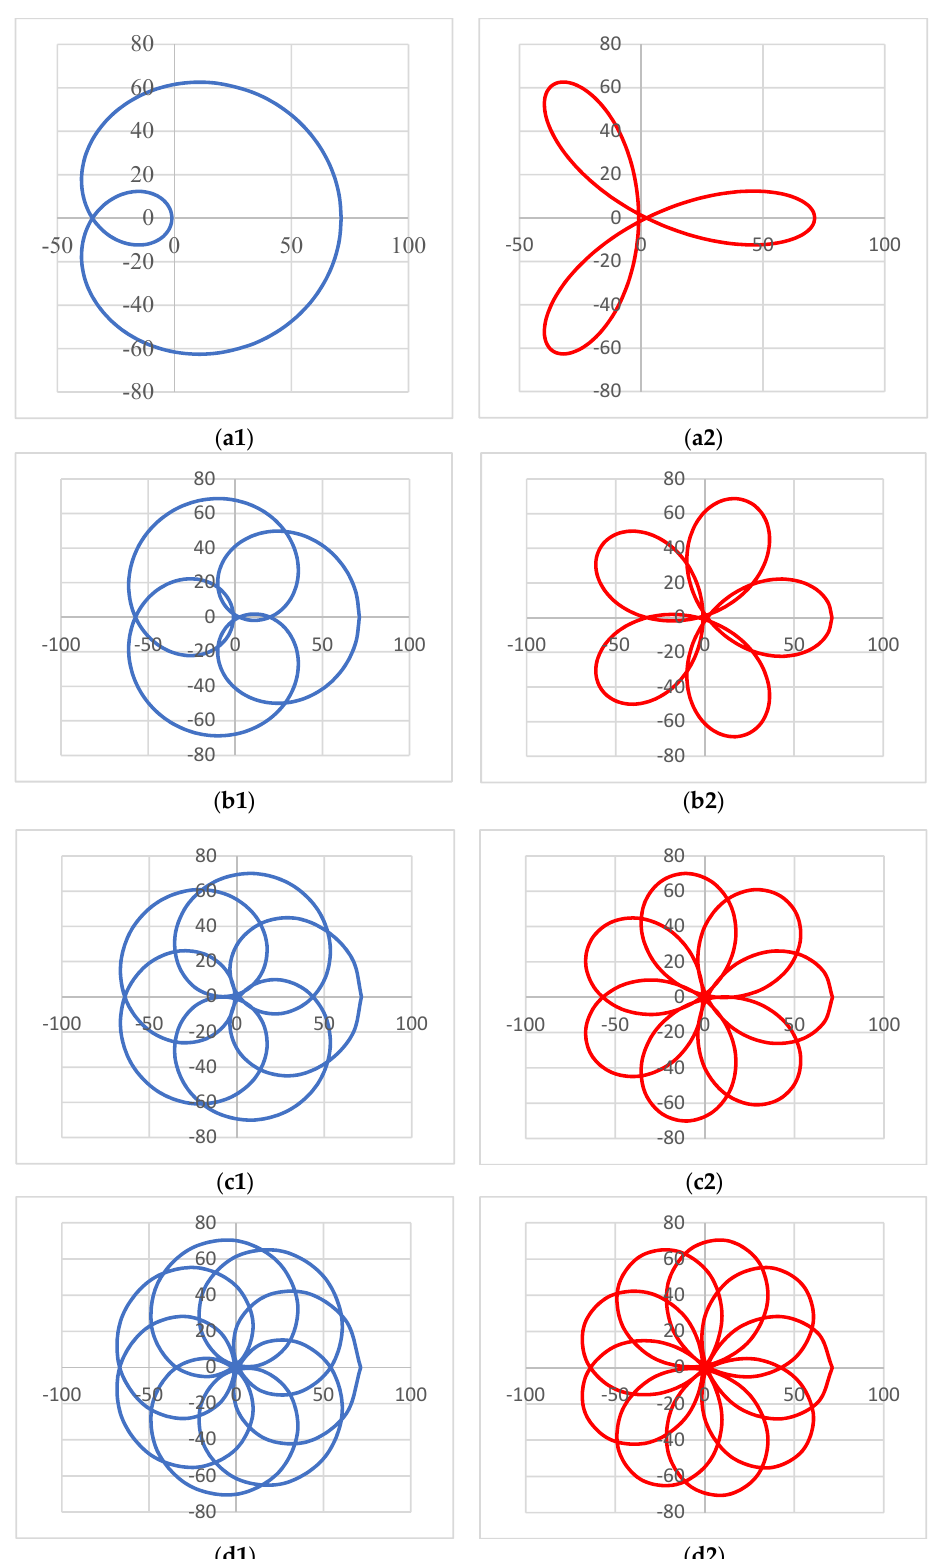
Figure 4. Study of the scan patterns produced by a pair of rotational Risley prisms (i.e., the configuration ba-ab in Figure 2d) for L = 1 m, e = 25 mm and for: ( a ) | M | = 2; ( b ) | M | = 4; ( c ) | M | = 6; ( d ) | M | = 8. ( 1 ) Left column, M > 0; ( 2 ) right column, M < 0 . The k = 1 case was considered for identical prisms with an individual deviation angle D = ( n − 1) θ = 2°. The values on the axes are in millimeters.